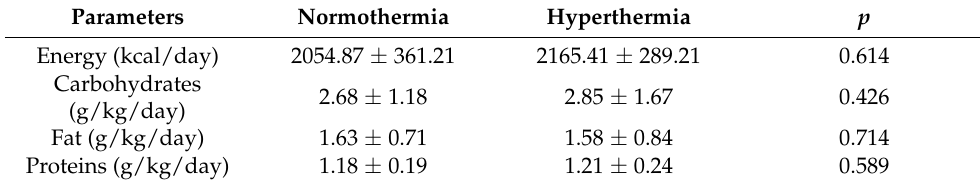
Table 2. Macronutrient intake before assessments.